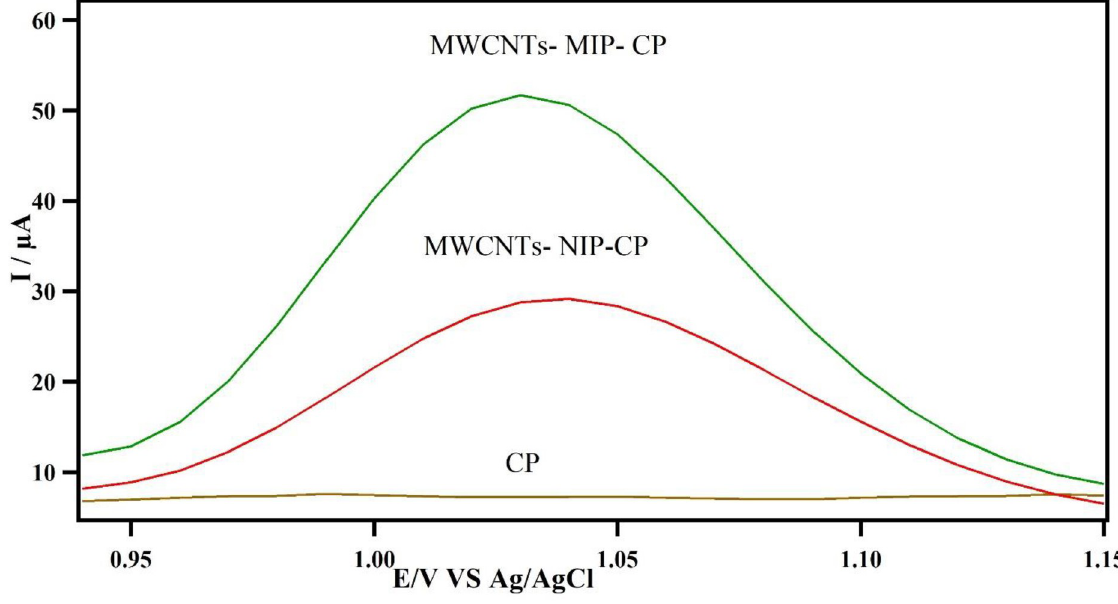
PLOS ONE | https://doi.org/10.1371/journal.pone.0279816 January 18,